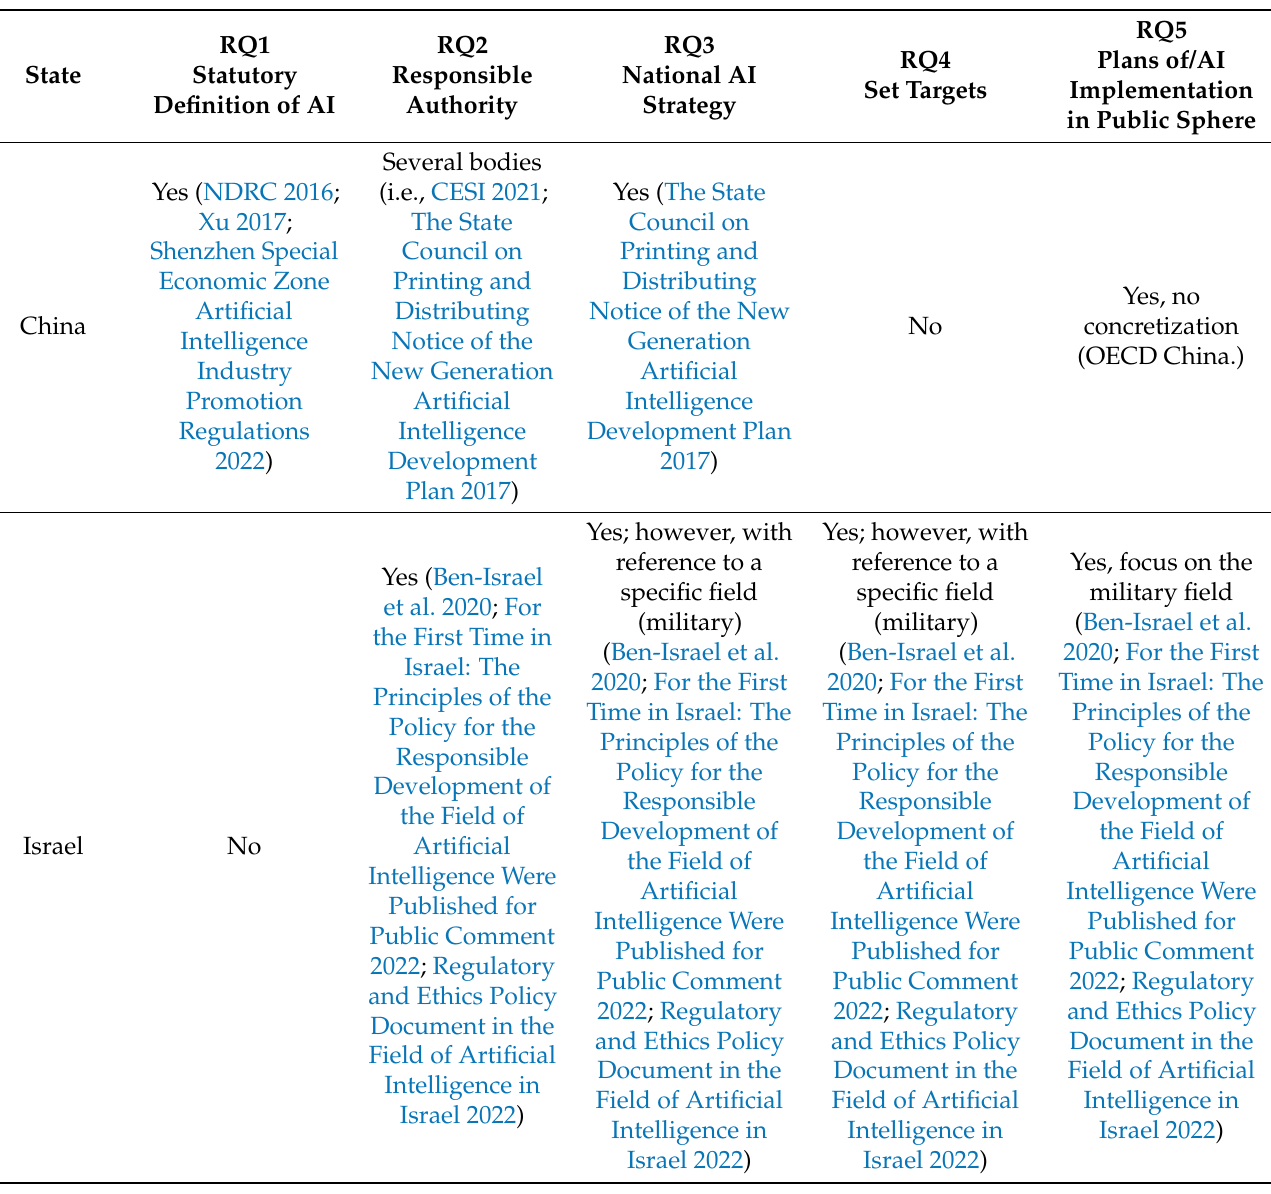
Table 5. Comparative analysis of national strategies in the field of AI of countries representing socialist, religious, and customary legal systems (compiled by the